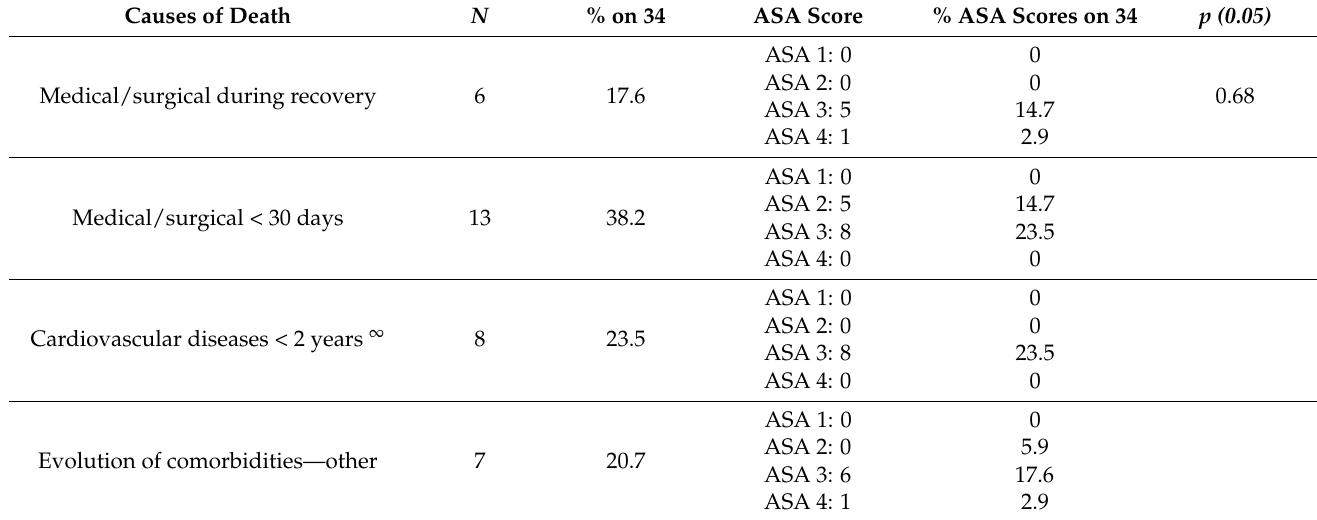
Table 2. Causes of death ( N ), ASA score, % on total deaths and % on ASA score, and p (0.05). Causes of Death